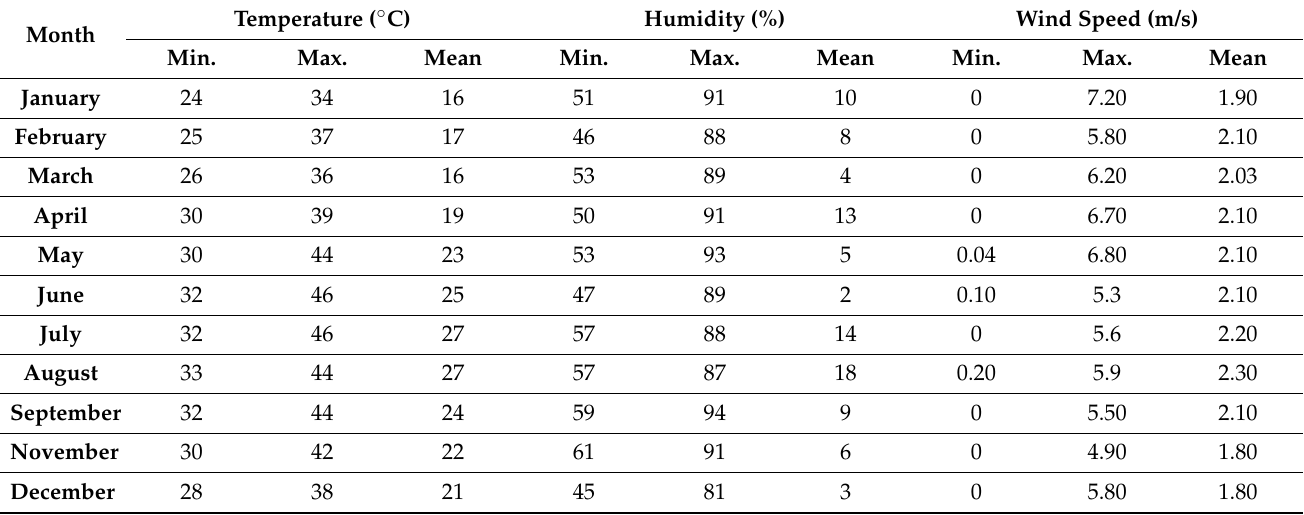
Table A1. The air temperature, relative humidity, and wind speed observed during the year.